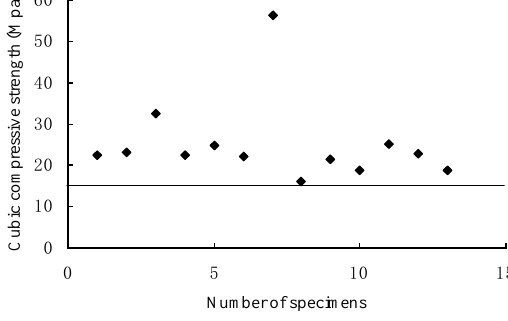
Figure 10. Cubic compressive strength of RFC.